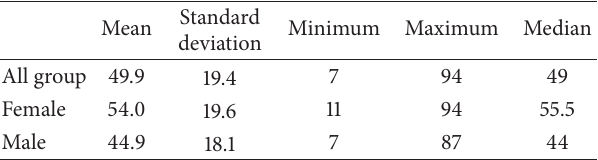
Table 2: The age distribution of the onset of symptoms associated with an aberrant right subclavian